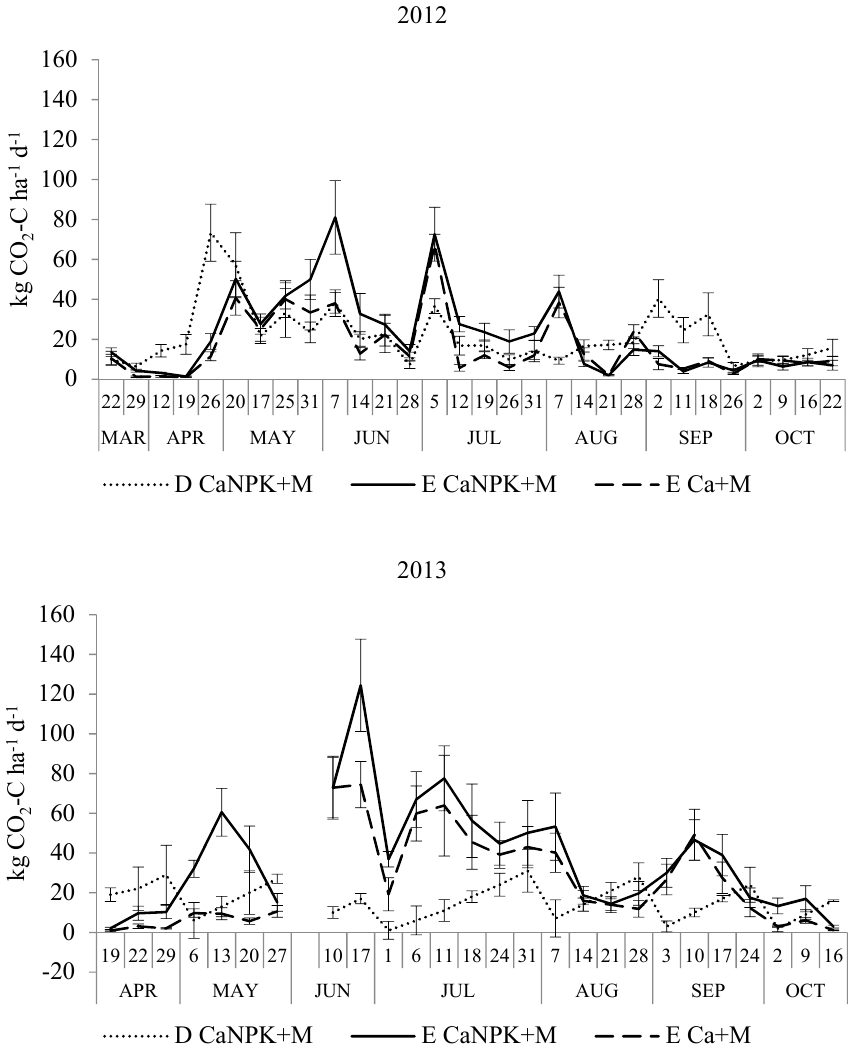
Figure 2. Daily CO 2 -C soil fluxes on Ca+M and CaNPK+M treatments under rye monoculture (D) and 5-crop rotation (E) experiments over the measurement period in 2012 and 2013.